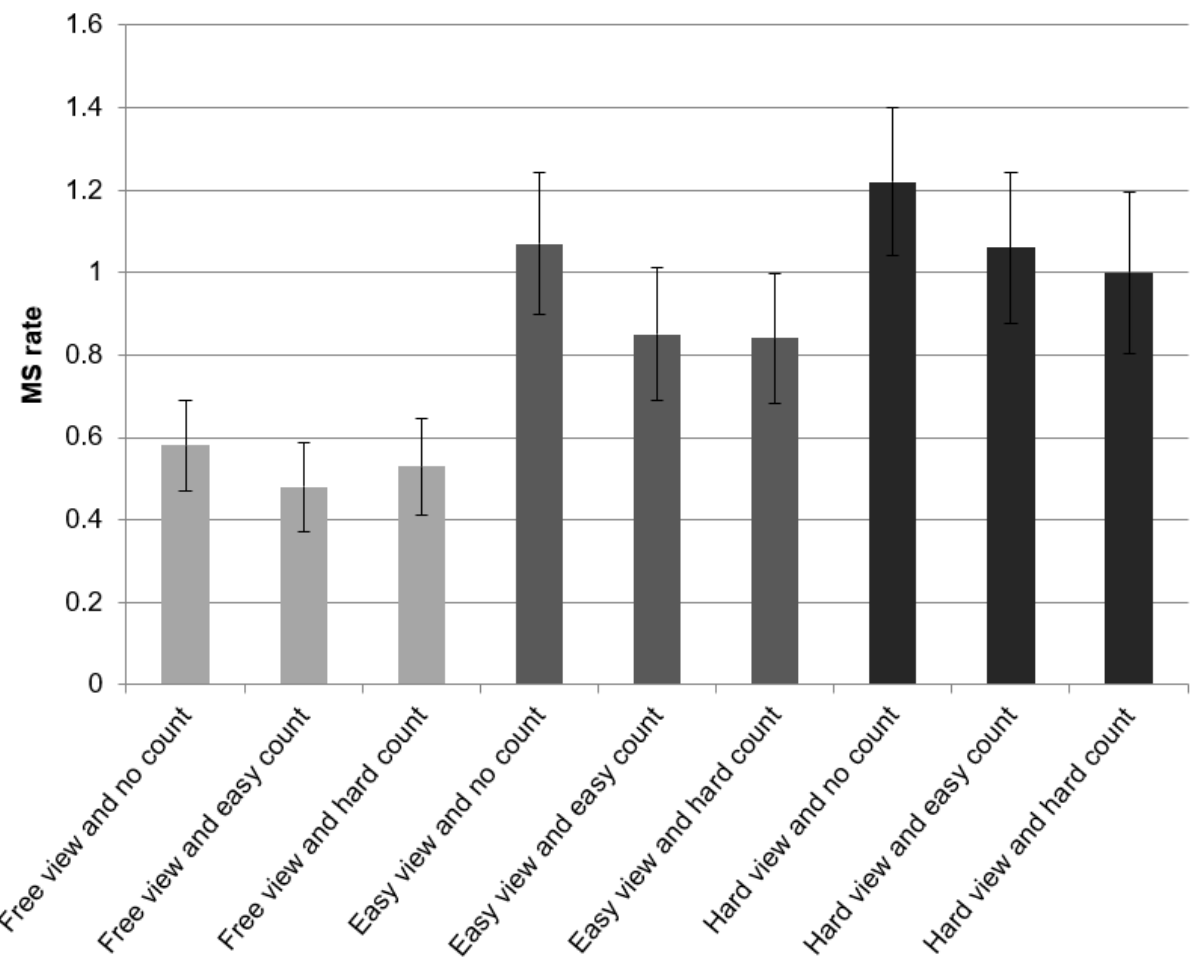
Figure 7. Microsaccade rate decreases when attention is directed towards the mental load task. Opposite, microsaccade rate increases when attention is directed towards the visual load